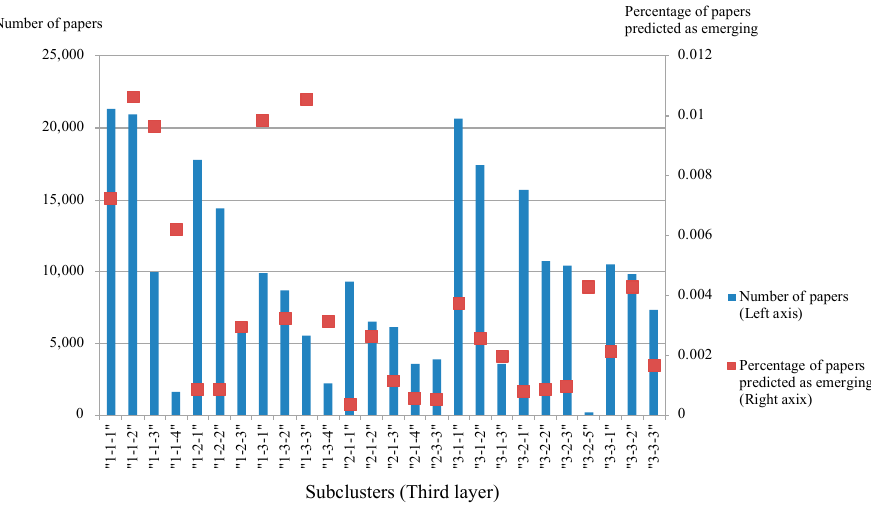
Figure 5. Frequencies of the top 1000 emerging papers by subcluster (third layer).